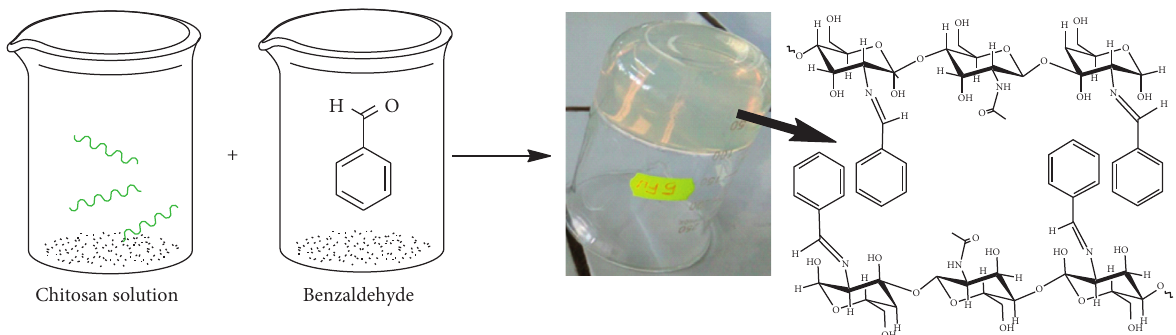
Figure 6: Chitosan-based hydrogel cross-linked with